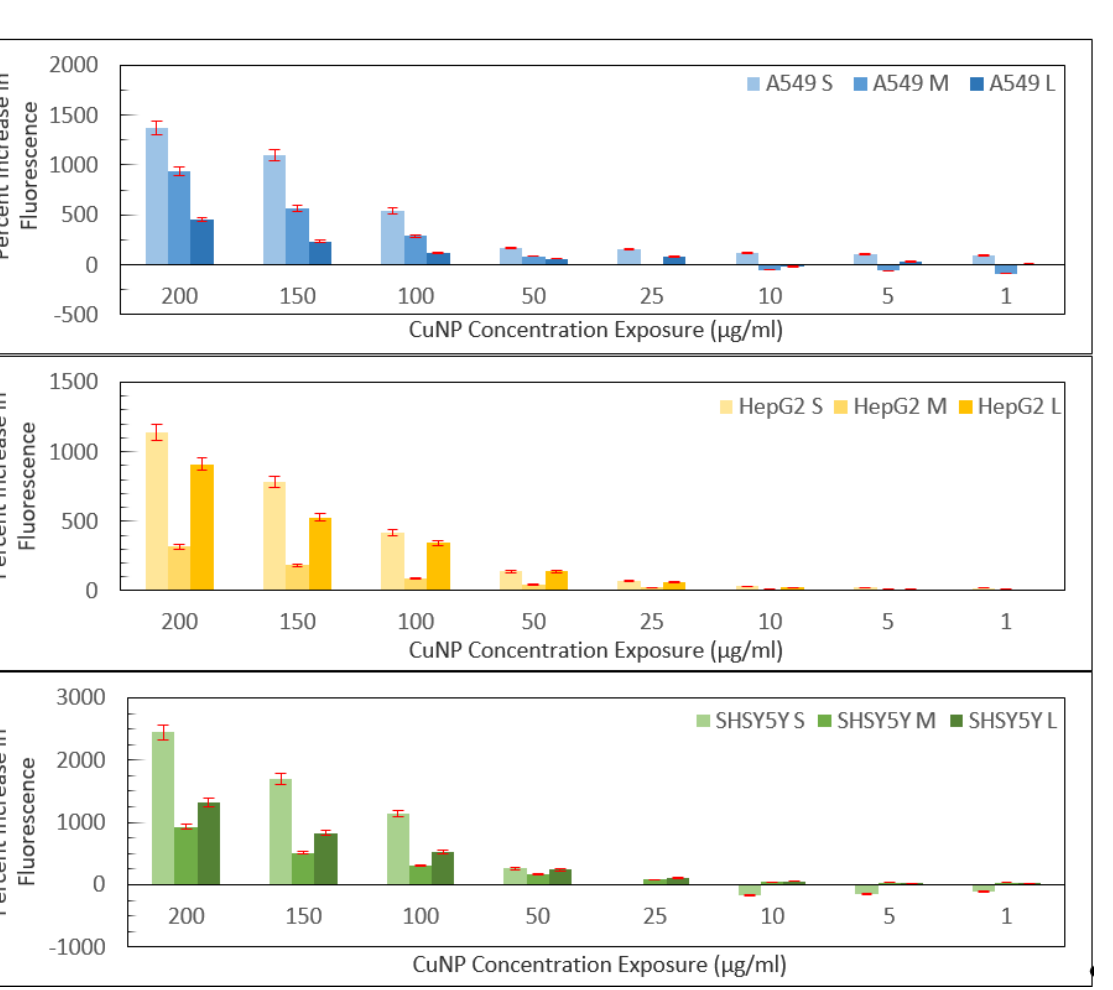
Figure 5. Cytotoxicity data for copper nanoparticles compared using three assays in three cell lines. Error bars are calculated as the standard error from three repetitions, each containing six replicates for each measurement.